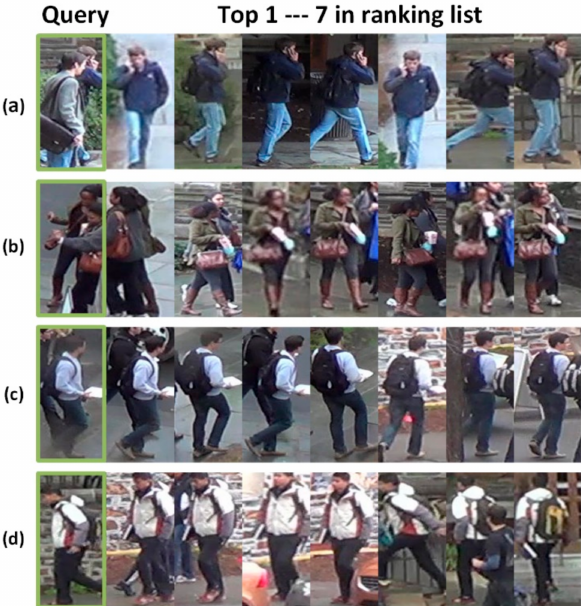
Figure 16. Four query images and query results of DBA-Net on DukeMTMC-ReID. ( a ) Sample 1. ( b ) Sample 2. ( c ) Sample 3. ( d ) Sample